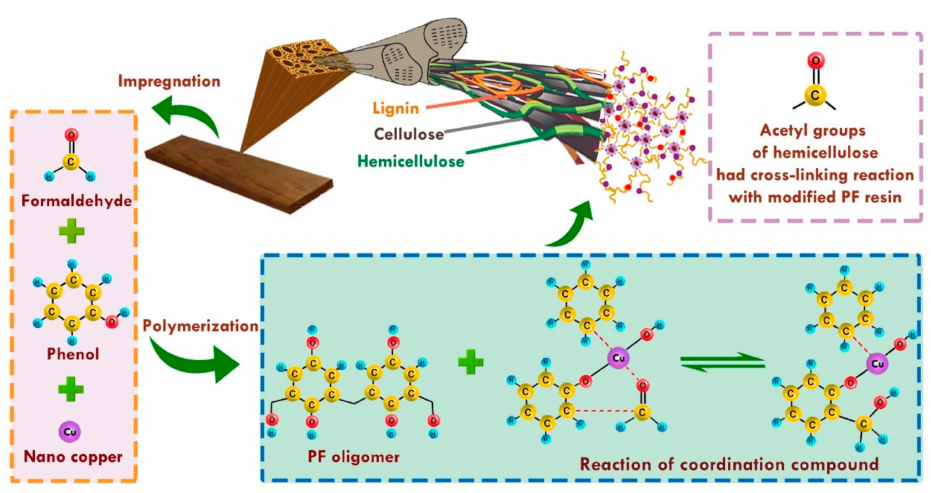
Figure 10. Schematic of the chemical reactions of cell wall components with nano-copper-modified PF